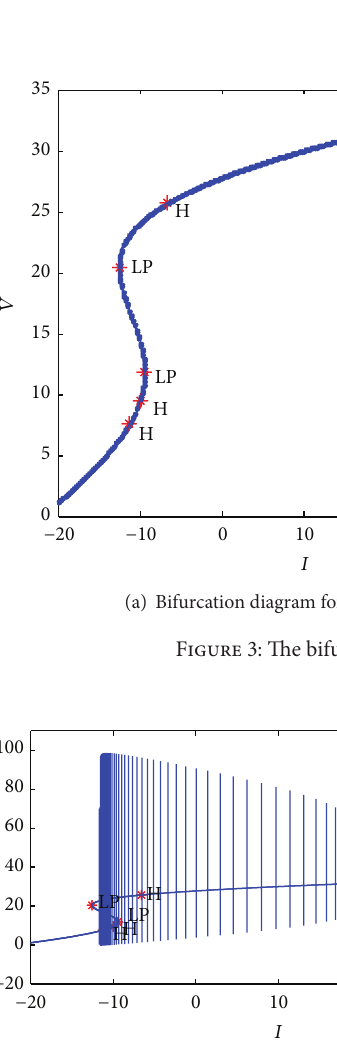
Figure 4: The limit cycle emerging from sH at 𝐼 = 20.428518 .